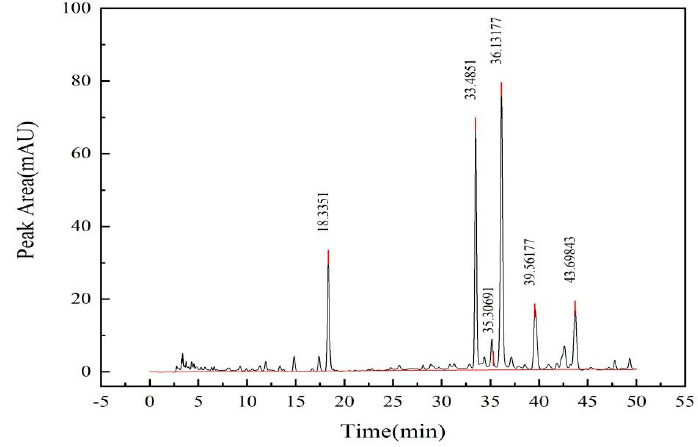
Figure 11. Detection results of liquid chromatography (column temperature = 30 °C; detection wavelength = 267 nm; injection volume = 10 μ L; flow rate = 0.8 mL/min).